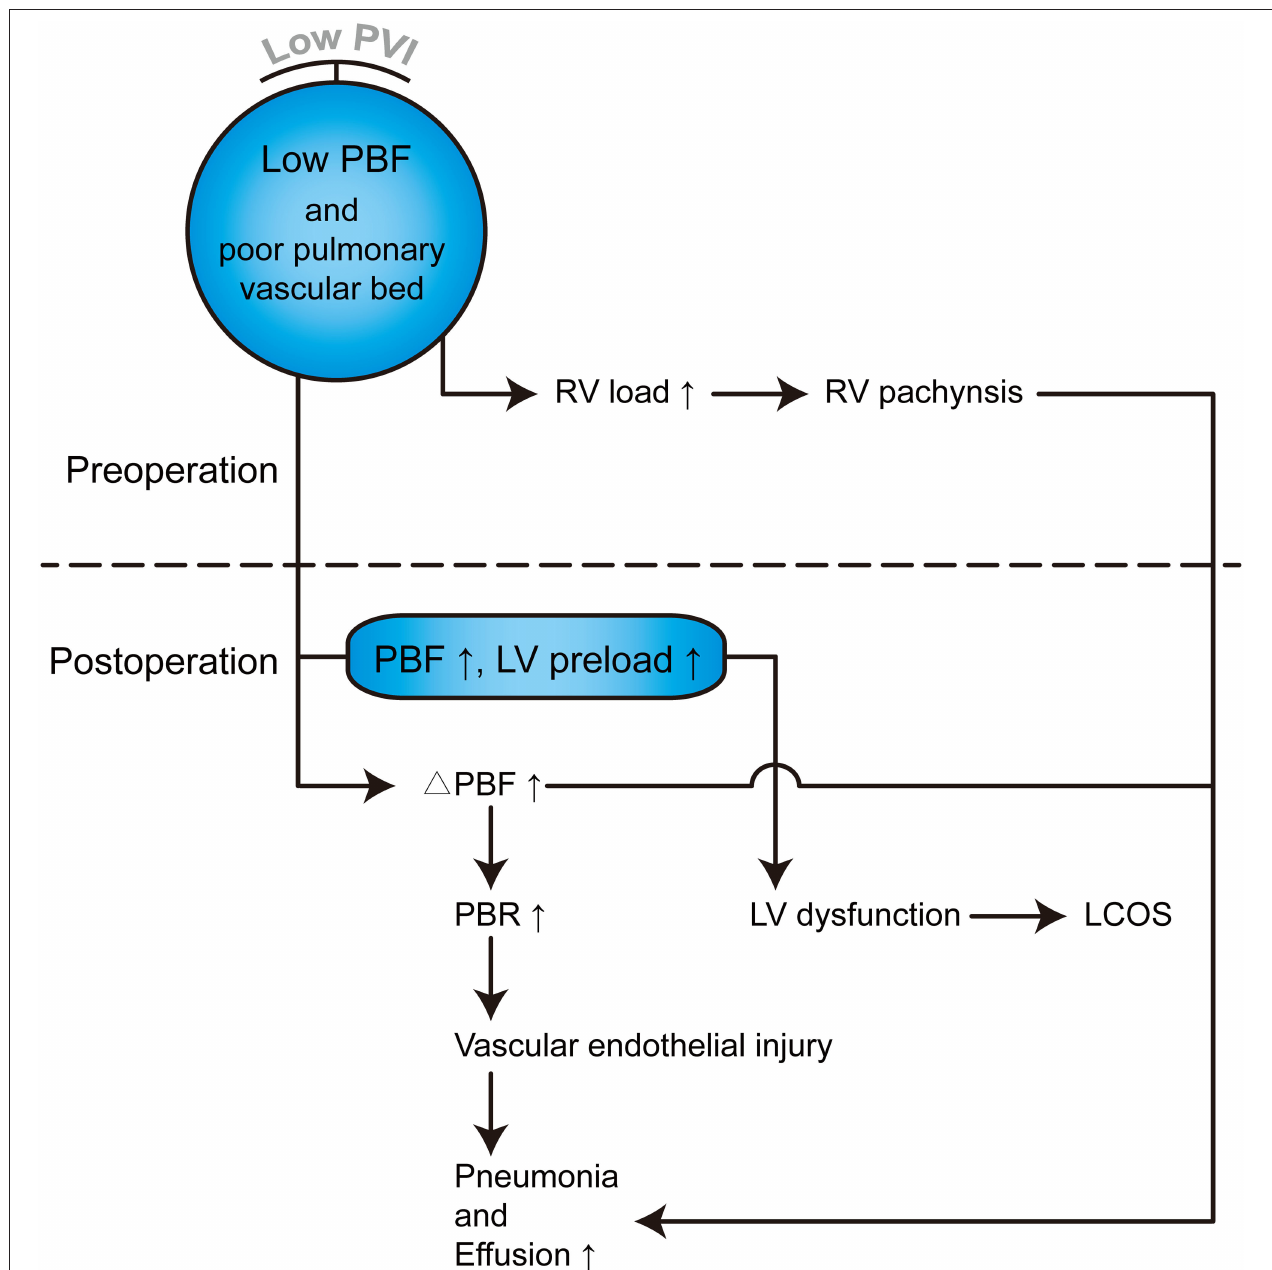
FIGURE 4 | Hemodynamic and pathophysiological changes in TOF patients with lower PVI. PVI can reflect the total PBF and pulmonary vascular bed, which can further reflect left and right heart pathophysiological changes. PBF, Pulmonary blood flow; RV, Right ventricle; LV, Left ventricle; 1 PBF, change in PBF postoperatively; PBR, Pulmonary blood flow rate; LCOS, Low cardiac output